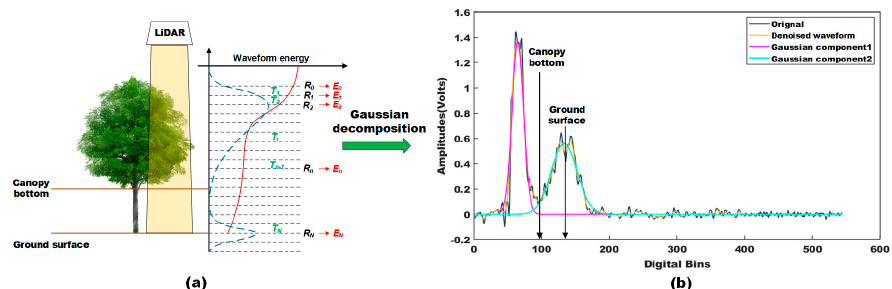
Figure 3. An example of processing the raw GLAS received waveform to obtain canopy bottom and ground positions by the Gaussian decomposition method. ( a ) is an example of GLAS observation for forest area; the blue dotted line is the GLAS received waveform ( R 0 , R 1 . . . , R n ), and the red line is the transmitted energy profile ( E 0 , E 1 , . . . , E n ); T i is the gap fraction between two successive recorded layers, which is equal to E i+ 1 / E i . ( b ) is the result of Gaussian decomposition; the raw GLAS received waveform is shown by the blue line, the denoised waveform is shown by the orange line, and the decomposed canopy and ground components are shown in pink and cyan, respectively. The positions of two arrows represent the detected canopy bottom and the ground position,